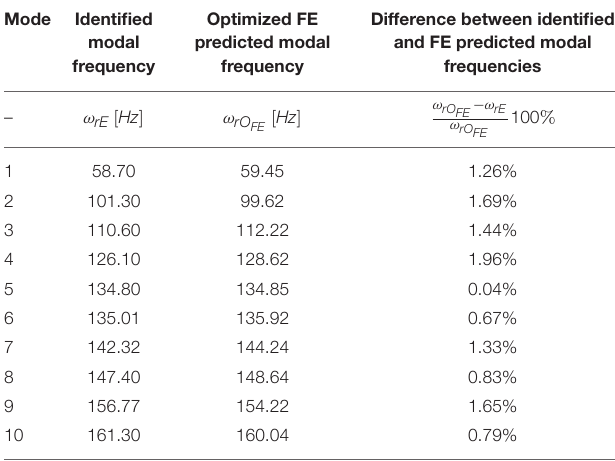
TABLE 3 | Identified and optimized FE predicted modal frequencies of the intermediate pressure turbine. Mode Identified